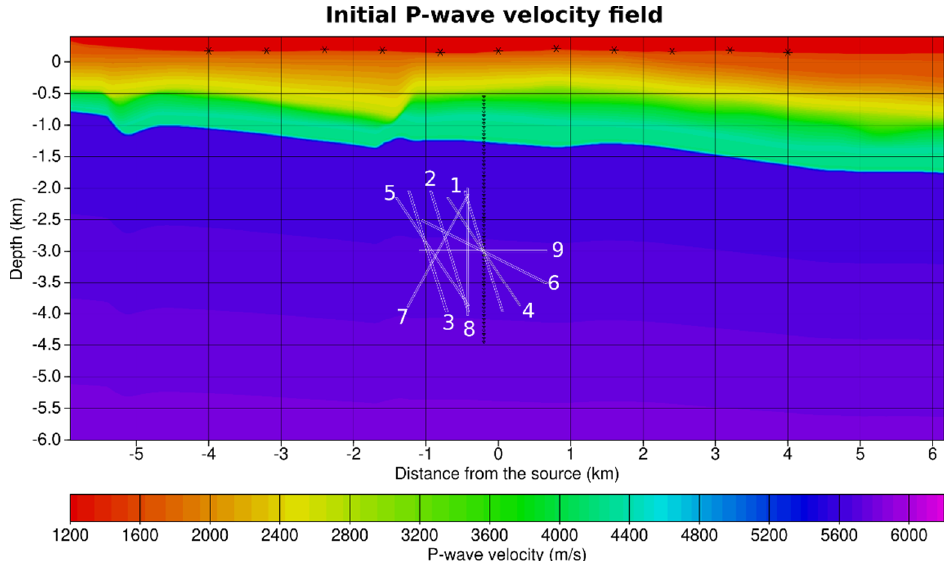
Figure 7. Different faults used in the sensitivity analysis with different dips shown on the P-wave velocity model. The center of the fault is at 3000 m depth. The faults are: (1) 75° dip, (2) 75° dip, shifted 600 m to the left (the lower part of the fault is about 200 m from the receivers), (3) 75° dip, shifted 800 m to the left, (4) 60° dip, (5) 60° dip, shifted 700 m to the left, (6) 30° dip, (7) -75° dip, shifted 650 m to the left, (8) vertical, shifted 200 m to the left and (9) horizontal, crossing the well at 3000 m. The stars show source locations and the reverted triangles, the receivers.